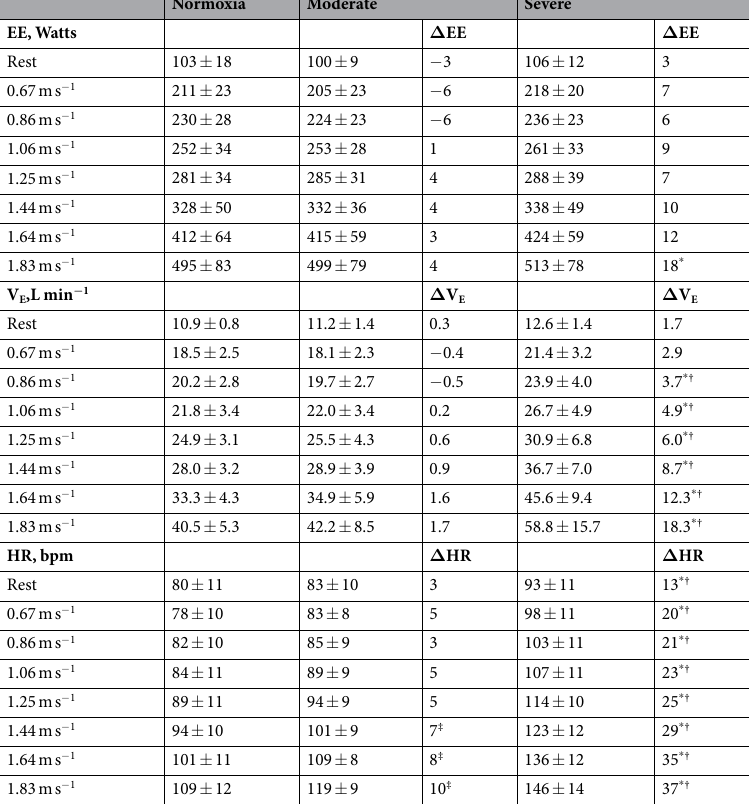
Table 1. Energy expenditure (EE), pulmonary ventilation (V E ), and heart rate (HR) at rest and each gait speed under three oxygen concentrations. Changes in these variables ( Δ ) under moderate and severe hypoxia versus normoxia are shown. Values are mean ± standard deviation. bpm; beats per minute. * P < 0.05 between normoxia and severe hypoxia, † P < 0.05 between moderate and severe hypoxia, ‡ P < 0.05 between normoxia and moderate